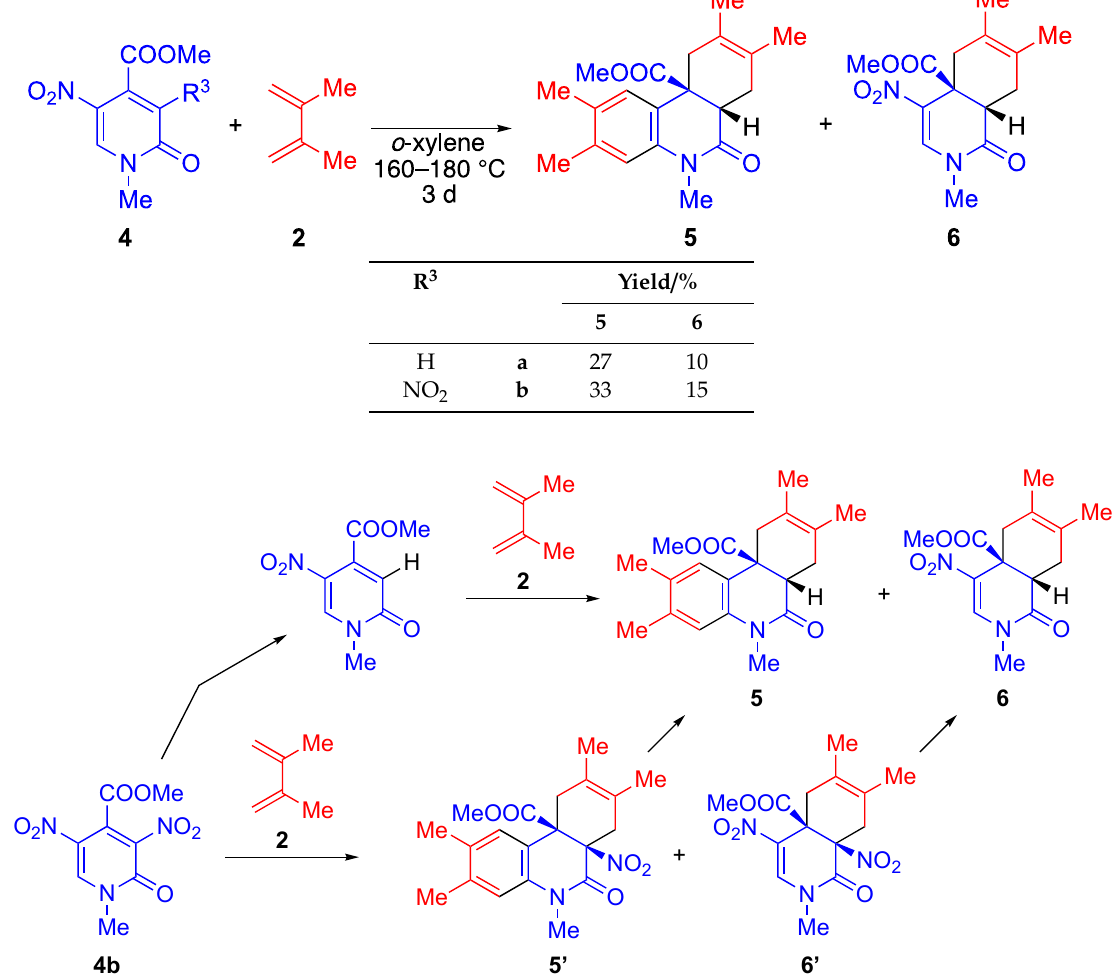
Table 2. D-A reaction of 5-nitropyridones 4 accompanying elimination of the nitro group.